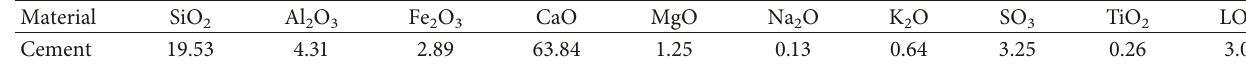
Table 1: Chemical composition of cement.